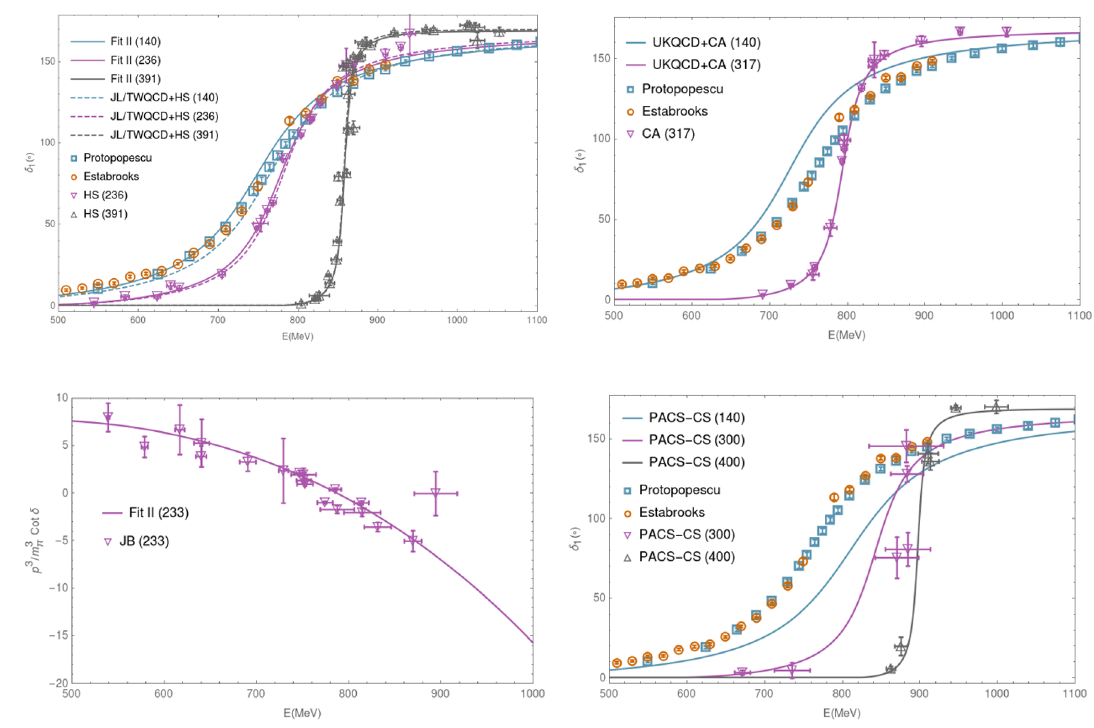
Figure 6 . Lattice phase shift data analyzed and (cid:12)t results obtained as explained in the text. For each (cid:12)t we also plot the extrapolations to the physical point in comparison with the available experimental data. The pion mass value (in MeV) for each simulation is given in parenthesis.